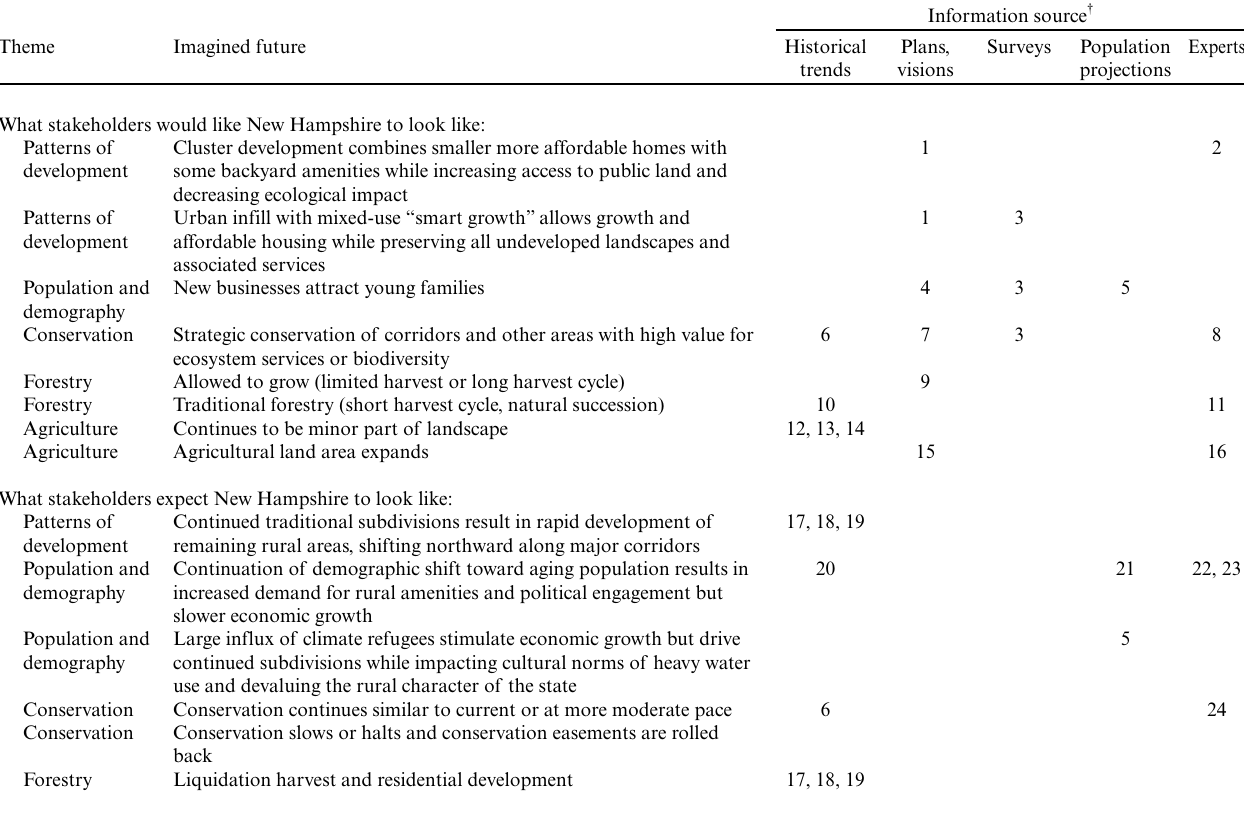
Table 2. Possible futures for New Hampshire that emerged from the six information sources we reviewed. Futures are organized by theme and by the two questions that were posed during key informant interviews interviews: (1) describe a picture of what you would like New Hampshire to look like in the future, two to four decades or more from now; and (2) describe a picture of what you expect New Hampshire to look like in the future. Supporting information, other than interviews, that was used to translate each idea into scenarios included: historical trends, plans and visions, surveys, population projections, and subject-matter